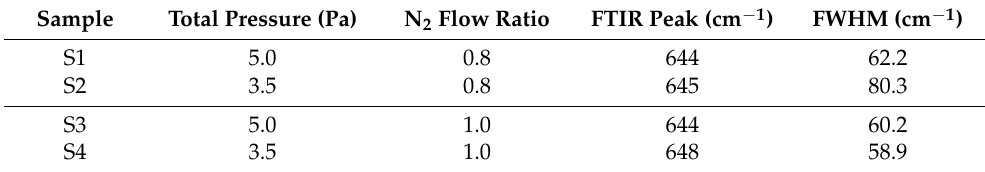
Table 5. Main parameters derived from the FTIR spectra. The FWHM values of the samples S1 and S2 have been estimated by considering the prominent peak and the small shoulder as a single peak.